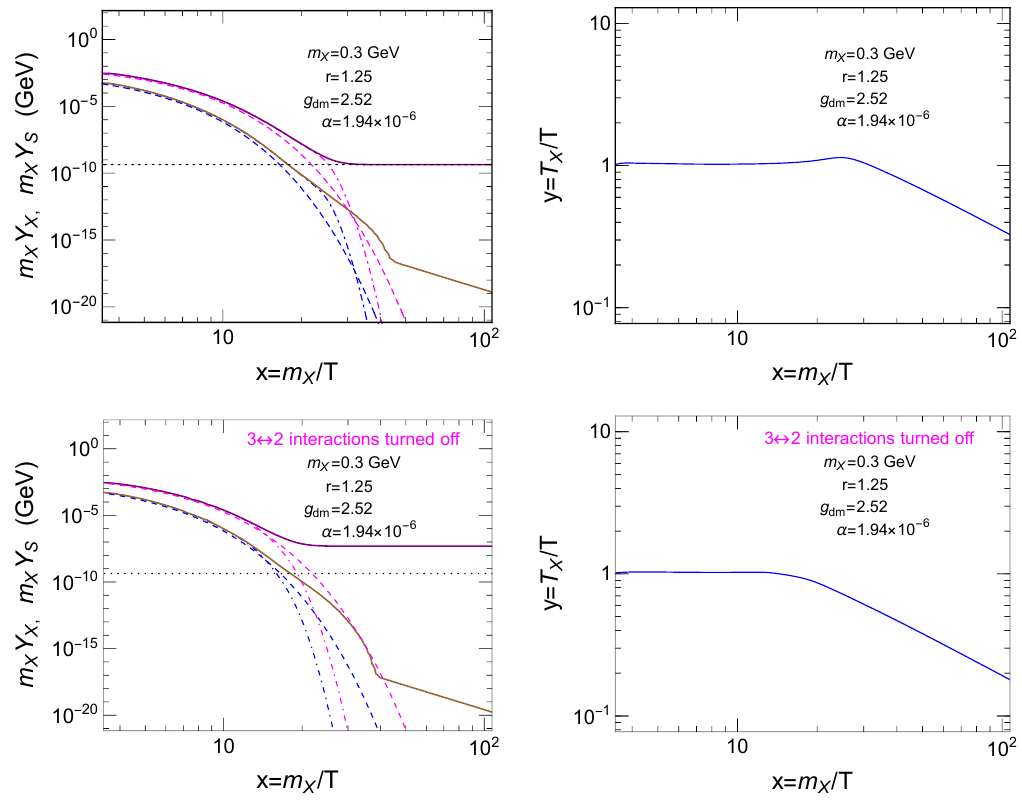
Figure 7 . Same as figure 4, but for the case denoted in the plots. The upper ones are in full consideration, while the lower ones are tuned off the cannibal